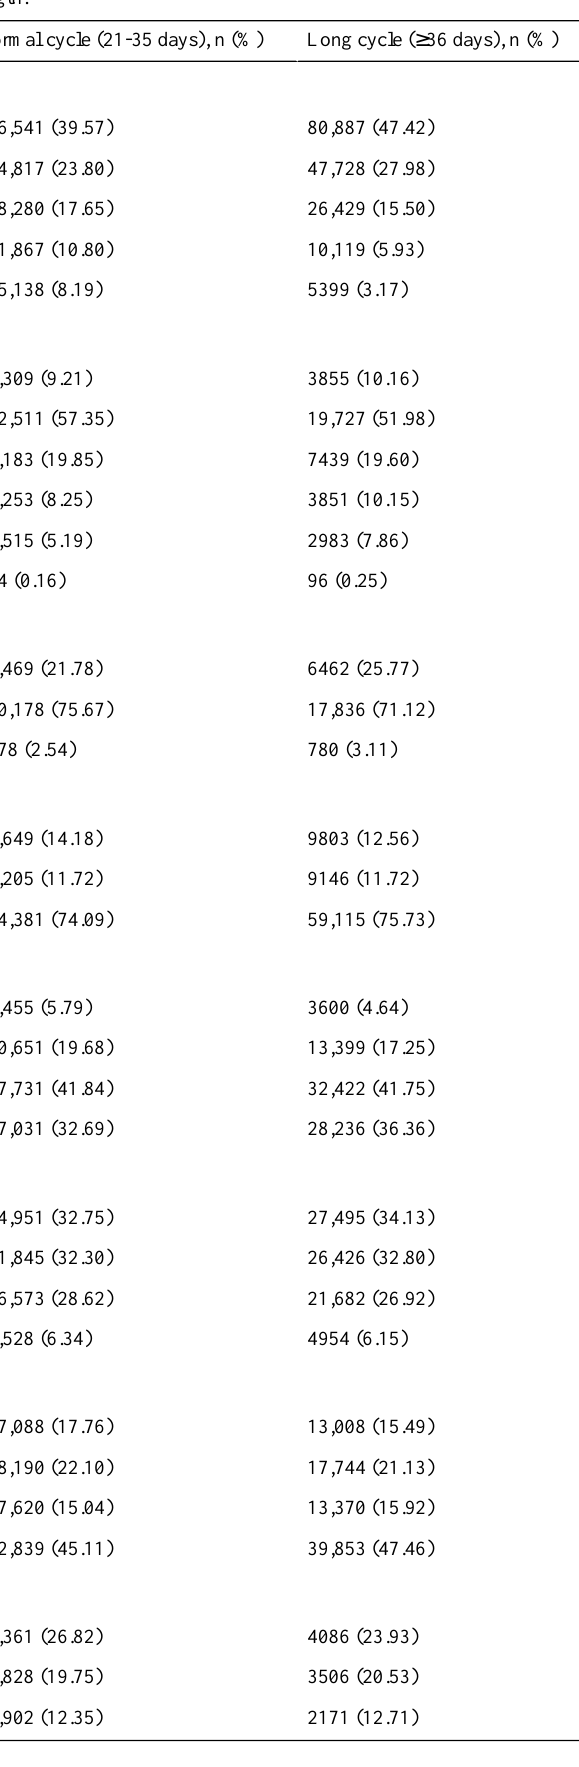
Table 2. Demographic and lifestyle characteristics across median cycle